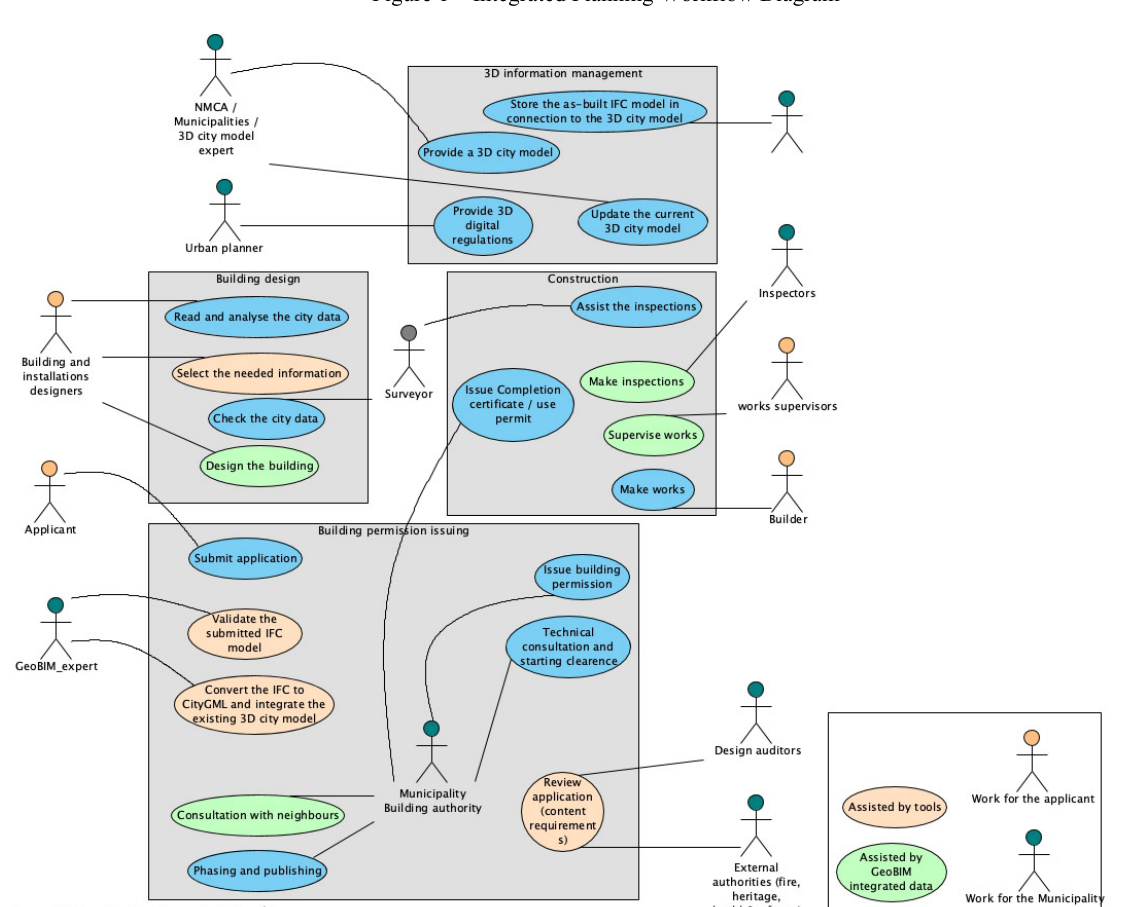
Figure 2 – UML Use Case Diagram for the Planning/Permits